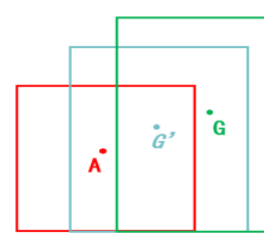
Figure 2. Process of correcting the anchor box.